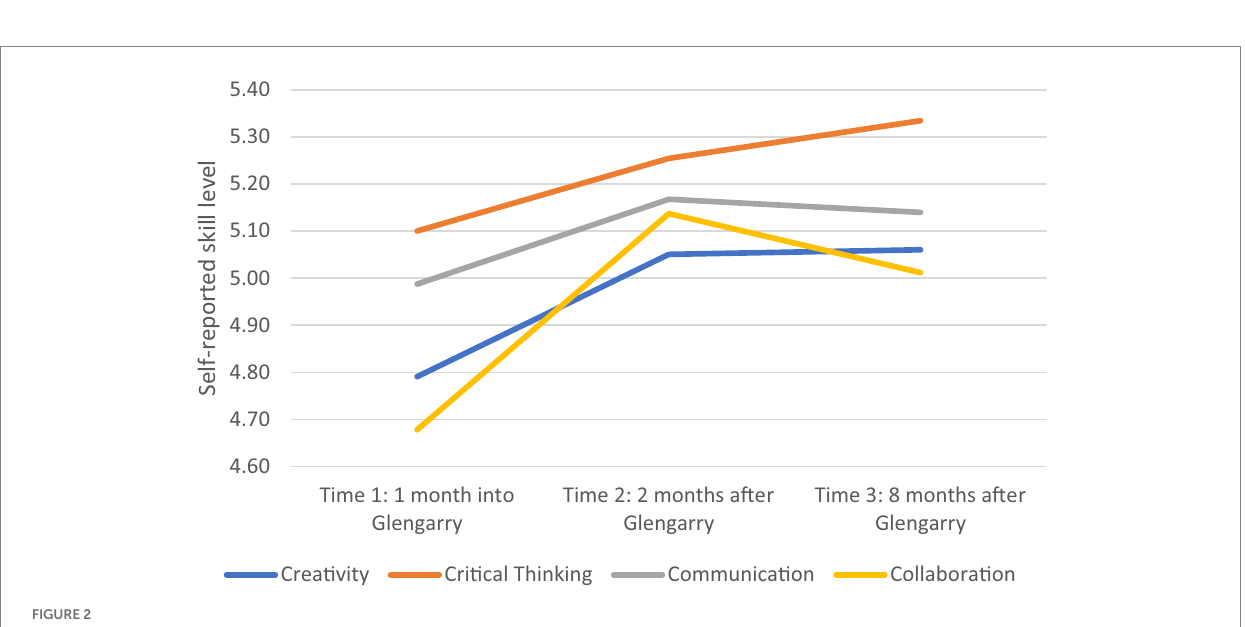
FIGURE 2 Intake 1 self-reported 21st Century skills at various time points.